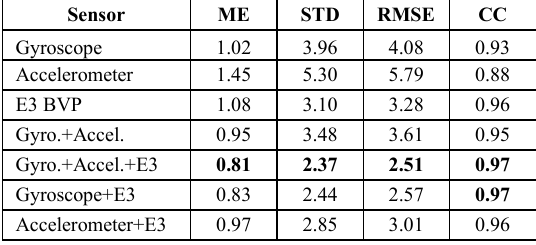
TABLE V. H EART R ATE E STIMATION DURING S LEEP (N: